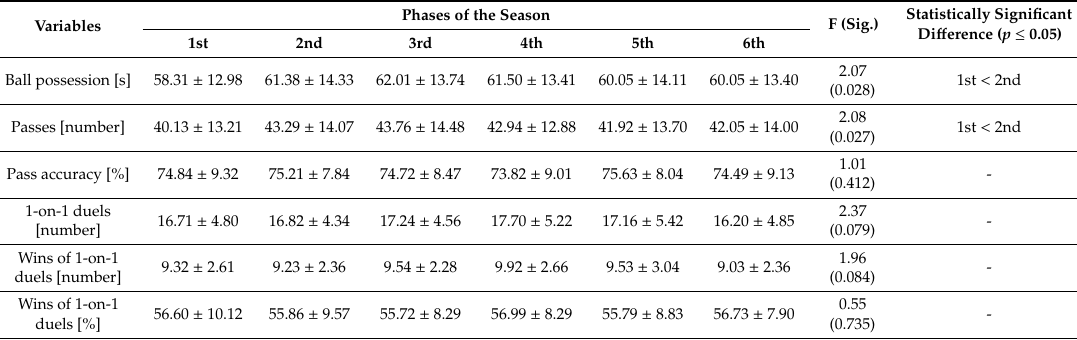
Table 2. Di ff erences in levels of technical performance achieved by soccer players in the Bundesliga, with regard to phases of the season (mean ± SD).